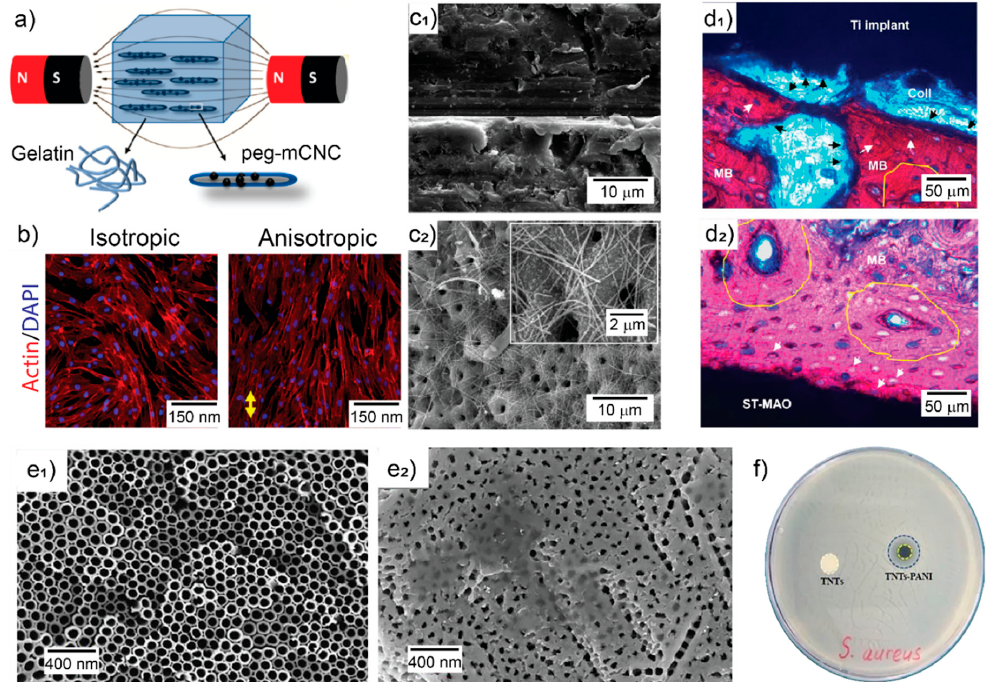
Figure 1. Scaffolds combining synergistic physicochemical cues for TERM . ( a ) Schematic representation of anisotropic hydrogel preparation and cross-linking under the influence of a uniform magnetic field. Rod-shaped nanocrystals coated with MNPs, polydopamine and polyethylene glycol were employed to generate a gelatin hydrogel with directional mi- crostructure and anisotropic mechanical properties. ( b ) Effect of isotropic and anisotropic hydrogels on human adipose tissue derived stem cells alignment after 3 days of culture (red, cytoskeleton; blue, nucleus). ( c 1 , c 2 ) SEM images of Ti im- plant and steam hydrothermal treated microarc oxidation coated Ti (ST-MAO), respectively. ( d 1 , d 2 ) Bone histology and histomorphometry around the Ti and ST-MAO implants, respectively, after 12 weeks of healing. (MB) mineralized bone; (black arrow) osteoblasts; (white arrow) osteocytes; (Coll) collagen birefringence; (yellow ring) osteon. ( e 1 , e 2 ) Field Emis- sion-SEM TNTs and TNTs coated with PANI, respectively. ( f ) Antibacterial effect showing zone of inhibition on S. aureus . ( a , b ) adapted with permission from [133] , American Chemical Society, 2019. ( c 1 – d 2 ) adapted with permission from [134] , American Chemical Society, 2015. ( e 1 – f ) adapted with permission from [135] , Elsevier, 2018. Developing facile ways of tuning interfacial properties of materials is important for modulating cell behavior. In reference [134], Zhou et al. reported the synergistic effects of hierarchical topography and surface chemistry of modified Ti implants for bone tissue engineering. The authors generated a porous coating of Ca, Phosphorus (P), Si and So- dium (Na) on Ti using microarc oxidation (MAO). Bioactivity was significantly improved introducing hydroxyl functional groups and increasing the apatite-inducing ability of the MAO coating by steam-hydrothermal treatment. The resulting surface exhibited a hierar- chical structural complexity with microscale pores (2 – 5 µm) and nanoscale HA wires and